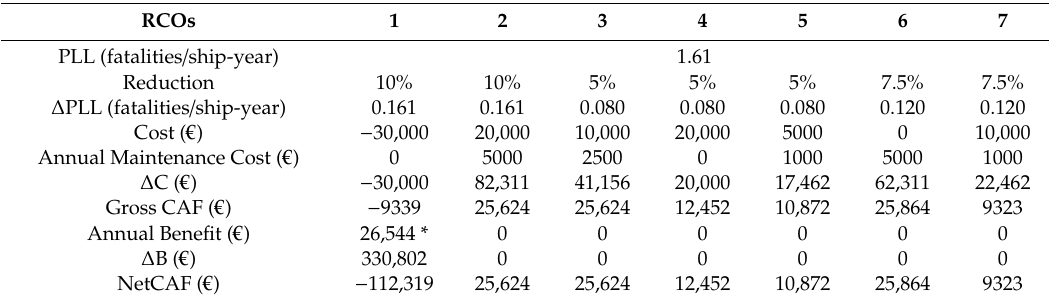
Table 18. Cost and benefit assessment of risk control options